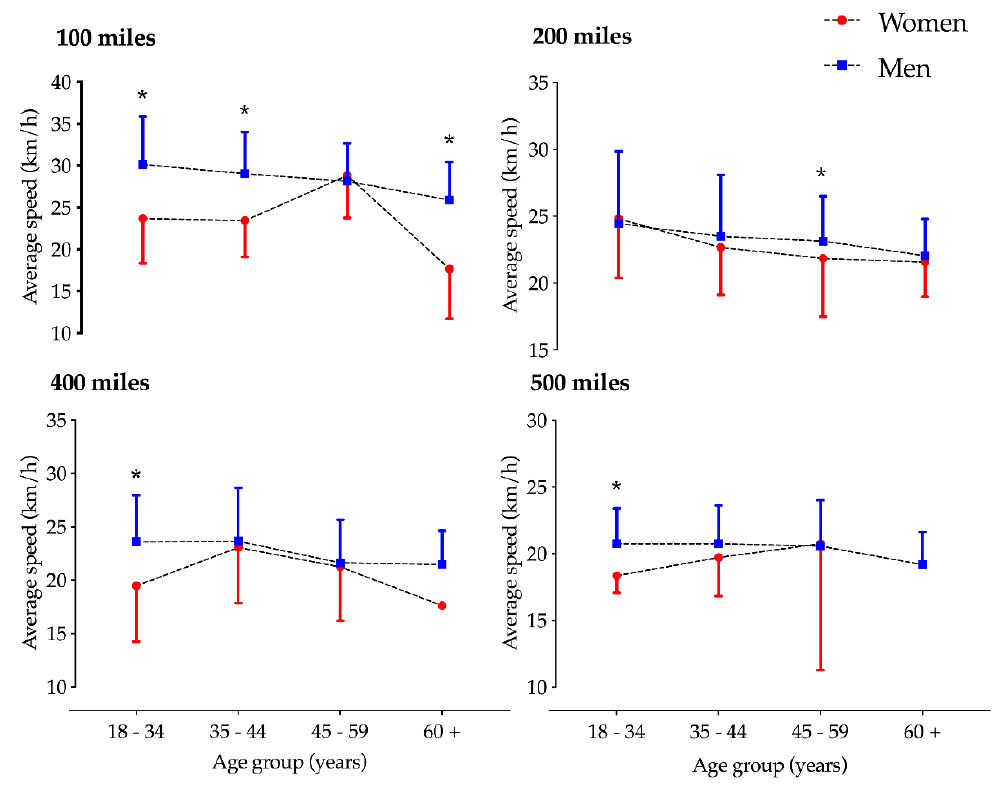
Figure 4. Performance trend by gender and age groups of participants in ultra-distance cycling (100 – 500 mile races). * Significant difference between men and women ( p < 0.05) in post-hoc analysis.